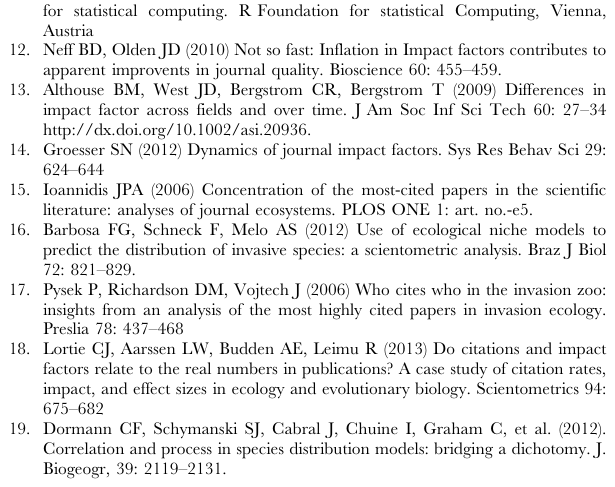
Table S2 Results of hierarchical partioning analyses showing the percentage of independent, joint and total explained variance for each considered